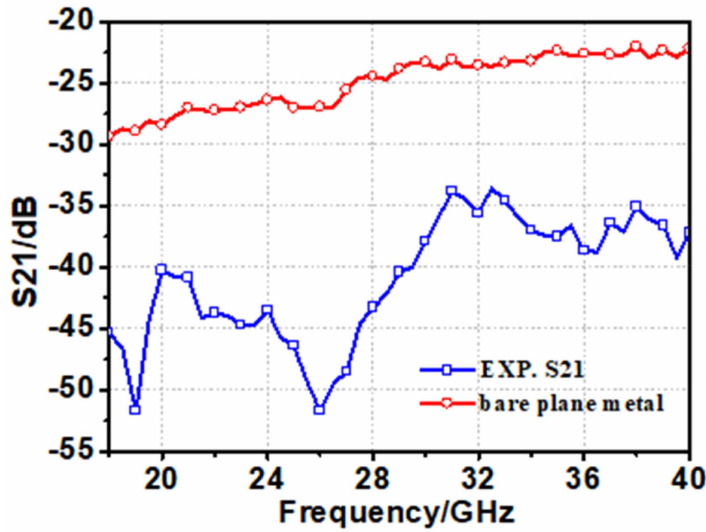
Figure 17. Comparisons of RCS between measured metasurface and a bare metal plane of the same